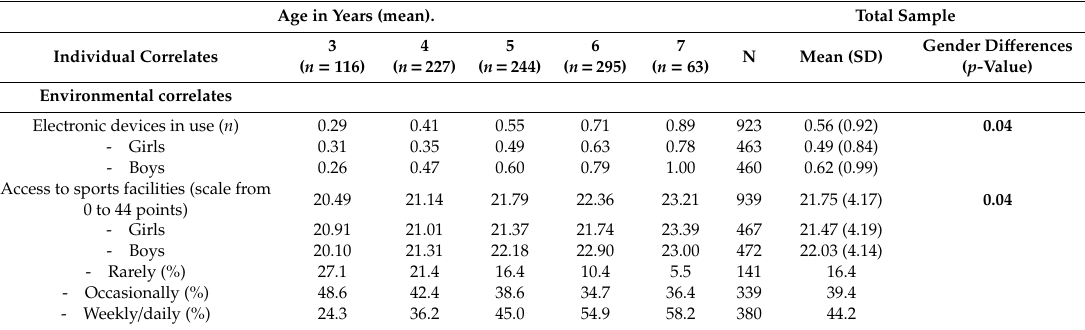
Table 1. Descriptive statistics of the study sample ( n =